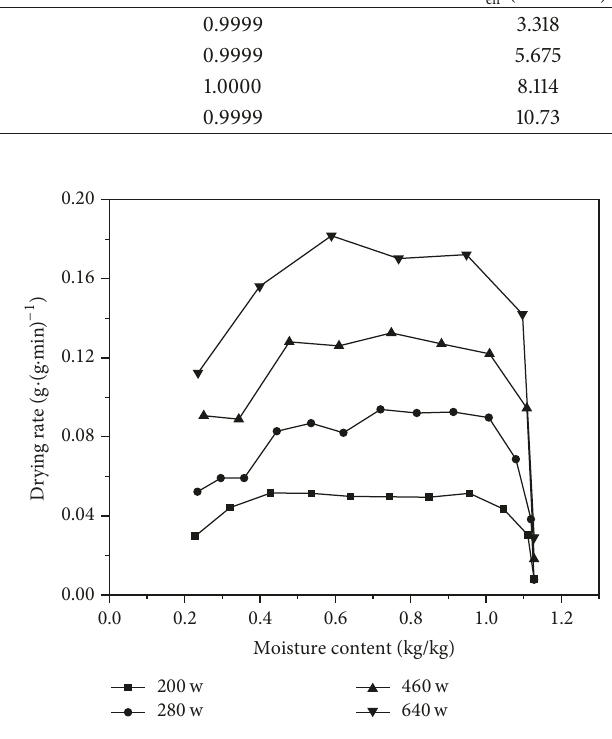
Figure 3: Drying rate of GB seeds under different microwave